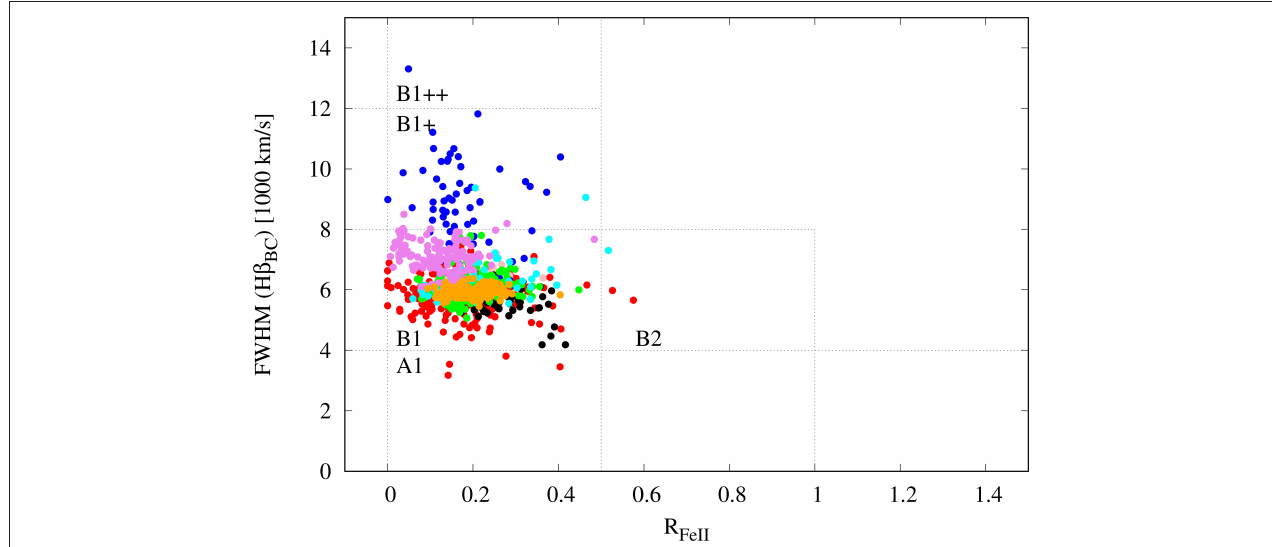
FIGURE 2 | The EV1 diagram of NGC 5548 spectral properties during 43 years of monitoring campaigns. Colors correspond to those in the Figure 1 .